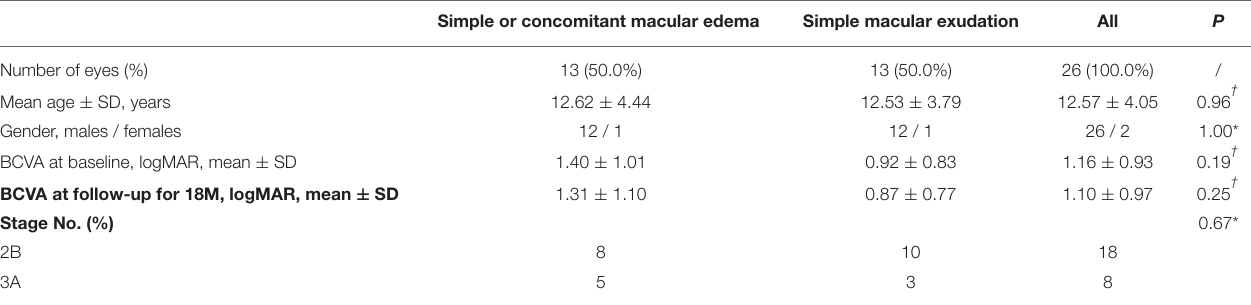
TABLE 1 | Demographic characteristics of eyes with Coats’ disease with macular edema or exudation. Simple or concomitant macular